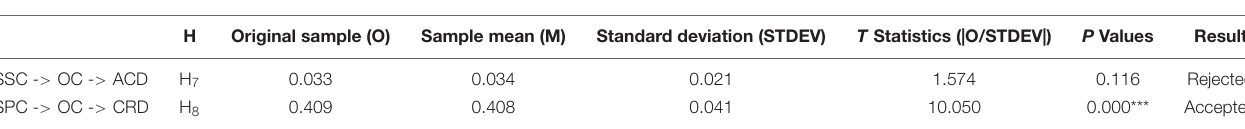
TABLE 6 | The indirect effects of the